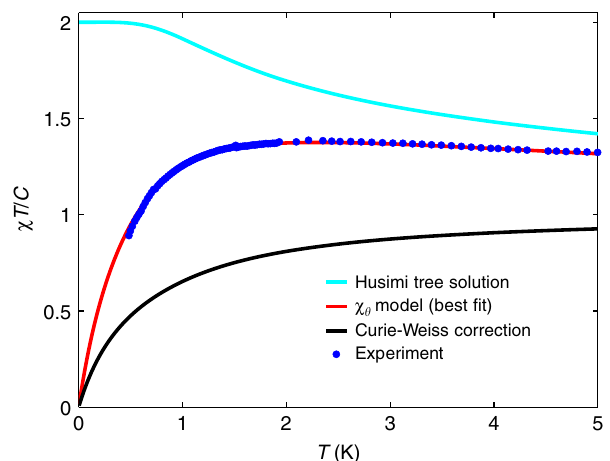
Fig. 2 Phenomenological susceptibility model for the inverting magnet Dy 2 Ti 2 O 7 . Husimi tree solution χ T / C for the NNSI model in cyan, the Curie – Weiss correction in black and their product, the best fi t to the phenomenological χ θ model (Eq. (10)) in red. Experimental data for Dy 2 Ti 2 O 7 are shown as blue fi lled primary magnetic interactions are the dipolar and short-range exchange interaction, and the materials are modelled by the dipolar spin ice model (DSM)